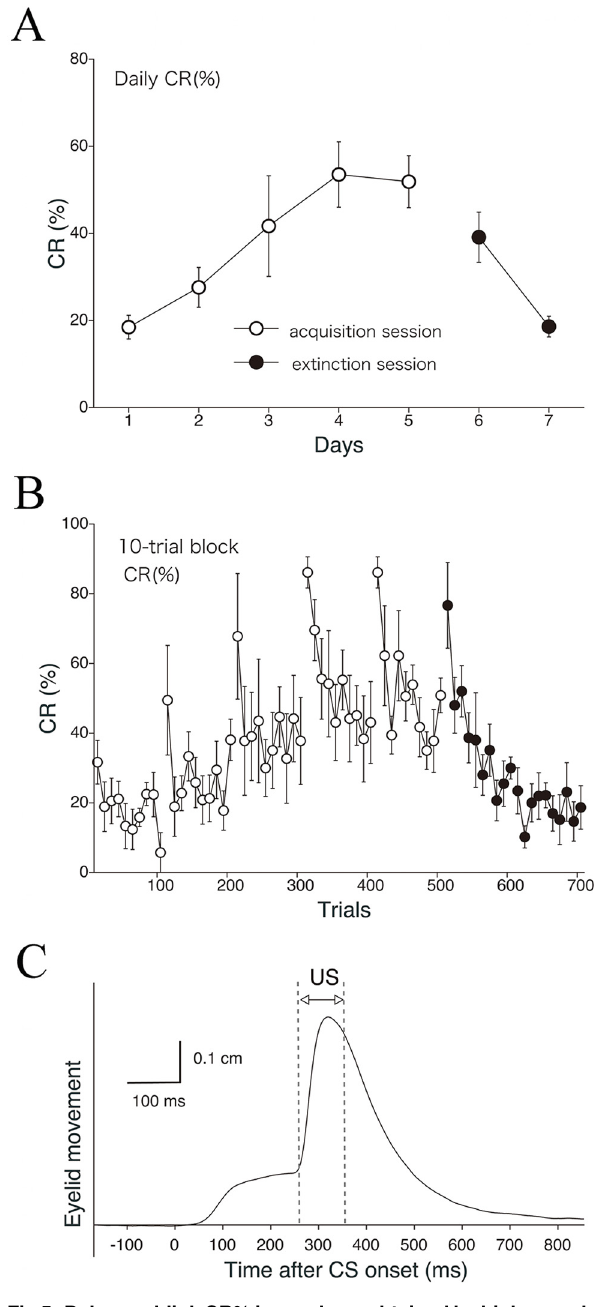
Fig 5. Delay eyeblink CR% in monkeys obtained by high-speed video analysis. The CR incidence (CR %) for all monkeys ( n = 5) is calculated on a daily (A) and 10-trial-block (B) basis with data from the Intelligent Vision Sensor. Monkeys received five acquisition and two extinction sessions. (C) A plot of eyelid displacement versus time during a session (average of all monkeys on day 5).